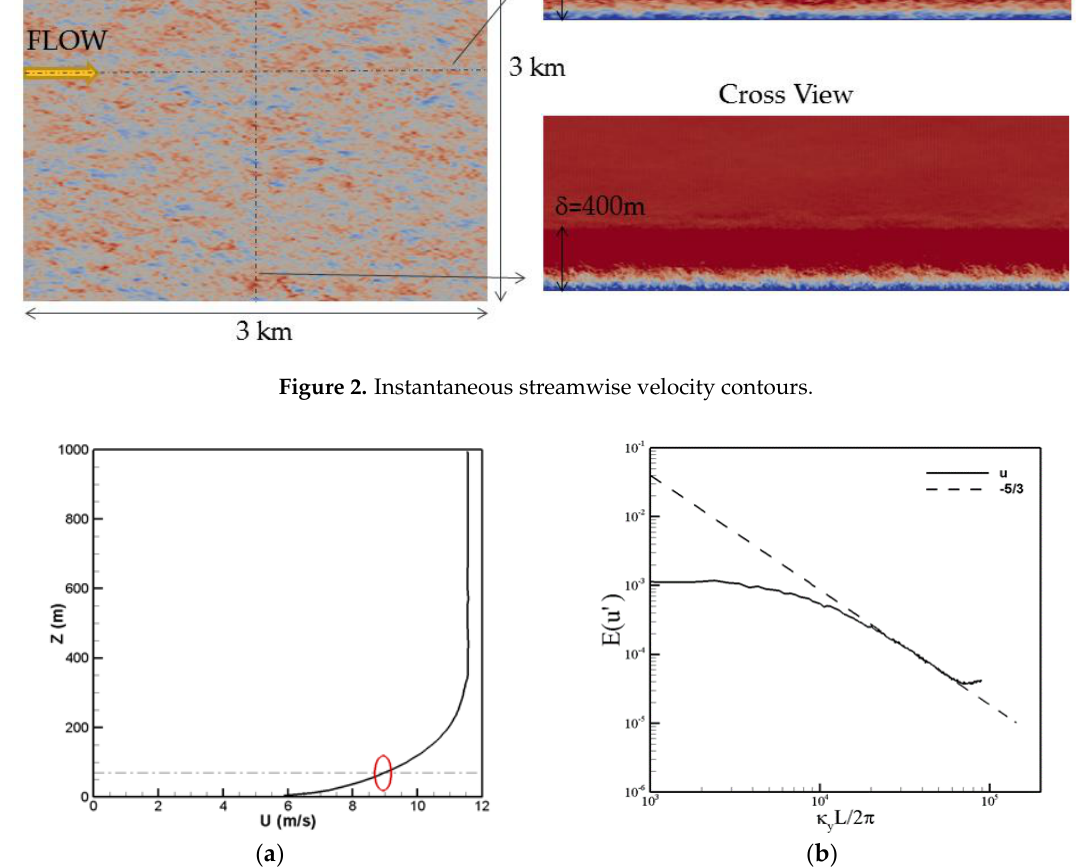
Figure 3. ( a ) Streamwise velocity profile with turbine rotor denoted by red circle and, ( b ) streamwise velocity spectra.